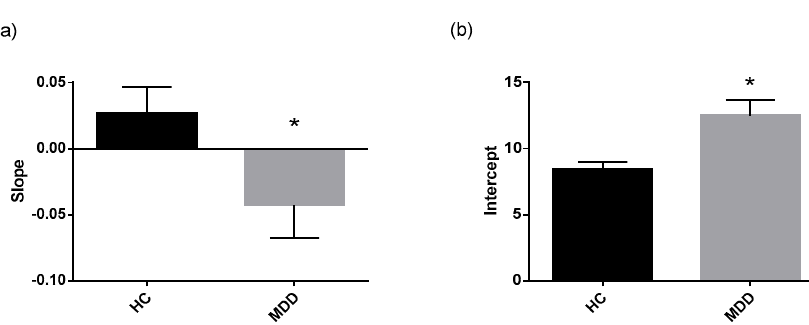
Figure 3. Parameters of regression line fit through morning cortisol data. Regression lines fitted through the morning cortisol data of each of the study group were significantly different. ( a ) The slope of the regression line and ( b ) the intercept of the regression line fitted through morning cortisol concentrations in depressed patients ( n = 57) compared to controls ( n = 41) are displayed as means with SEM. * p ≤ 0.05 vs. control (Mann Whitney-U test on log transformed data).